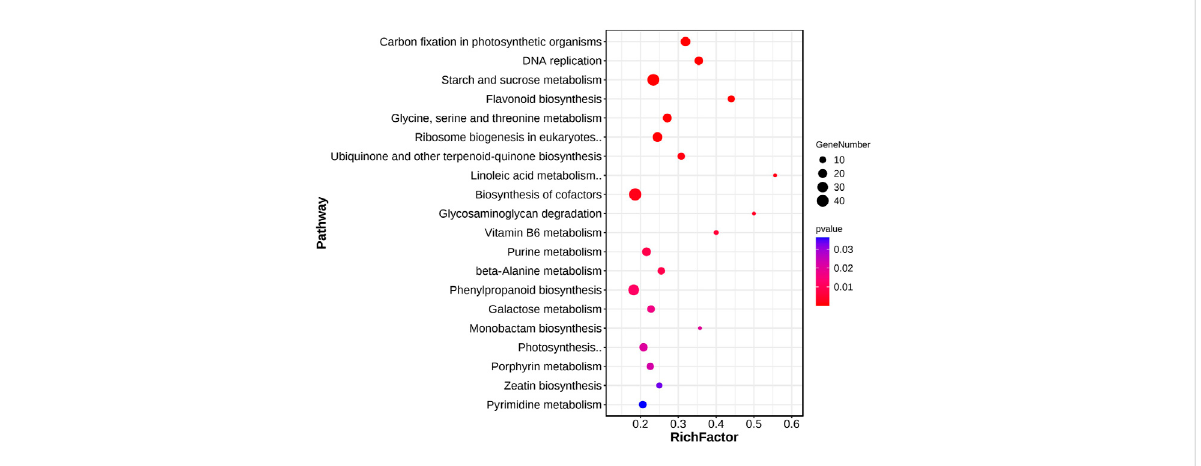
FIGURE 3 KEGG analysis of common DEGs. KEGG analysis of 3,798 common DEGs. The blot color and size represent the signi fi cance and number of DEGs enriched for this pathway, respectively. Terms with a p -value <